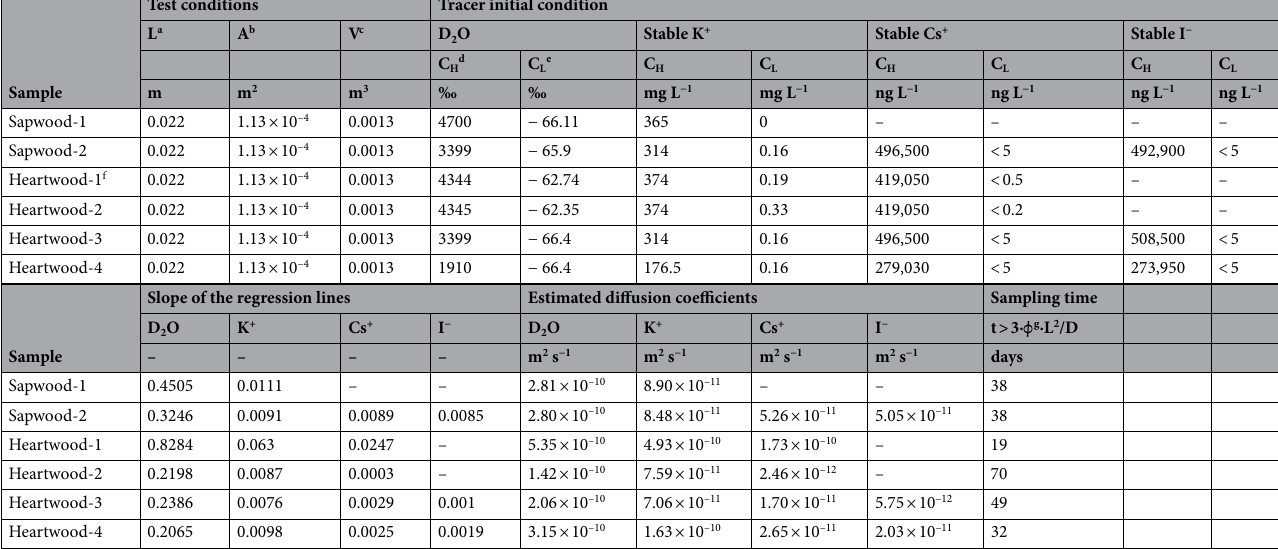
(Figs. 1a, 2; Table 2), together with the fact that a radially heterogeneous distribution of 137 Cs has been found in xylem stems by field observations in the past 6 years 6,9 . The circulating behavior of water (including D 2 O) is irregular in heartwood because the heartwood zone gradually loses permeability owing to the deposition of materials such as large organic molecules. Consequently, the D 2 O concentration changes in the permeable sap- wood zone varied more quickly than that in the relatively impermeable heartwood zone (Figs. 1a, 2c,d, Table 2). The large differences we observed in residence time and mobility of D 2 O between the sapwood and heartwood (Figs. 1, 2; Table 2) indicate that the sap flow in the tracheids of the sapwood caused strong radial diffusive trans- port within the tree stem 9,17,20 . Thus, the xylem sap in heartwood was not supplied directly from soil water via root uptake but was instead supplied from the sapwood by diffusive transport caused by sap flow in tracheids or vessels 17 . A comparison between changes in the positive δD signal (Fig. 2) and those in the magnitude of radial diffusive D 2 O flux (Table 2) supports the abovementioned and belowmentioned simulation results. We predicted the migration of D 2 O and 137 Cs in the radial xylem (from sapwood to heartwood) in sugi stems by using a one-dimensional advective diffusion transport model with the instantaneous pulse input given by the delta function and the measured diffusion coefficients in this study. The equation 37 is as follows: